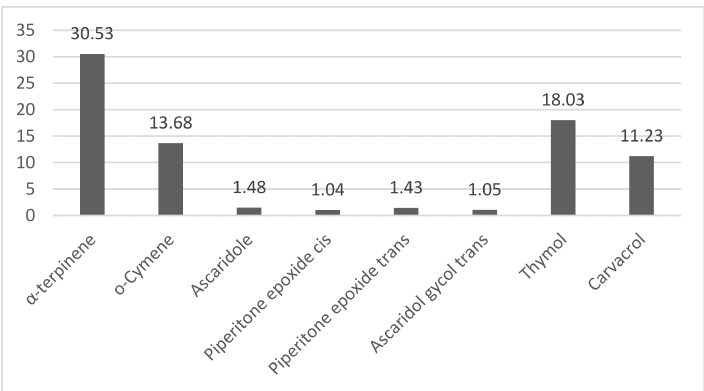
Figure 1. Histogram profile of the Dysphania ambrosioides essential oil composition.